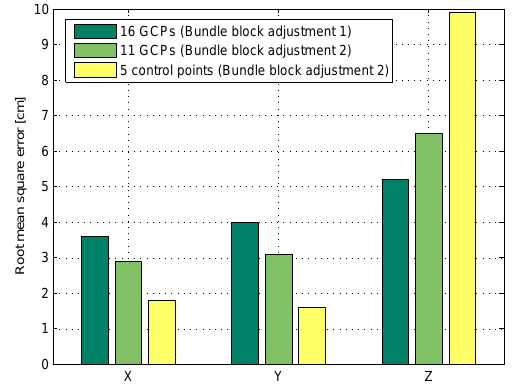
Figure 11: Root mean square error of GCPs and control points using either 16 GCPs (and thus no control points) or 11 GCPs and 5 control points.